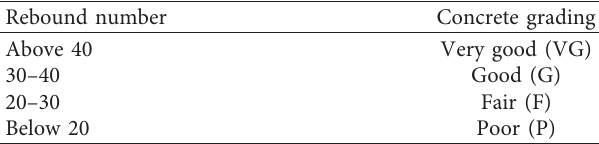
Table 7: Grading of concrete using the rebound number [8].